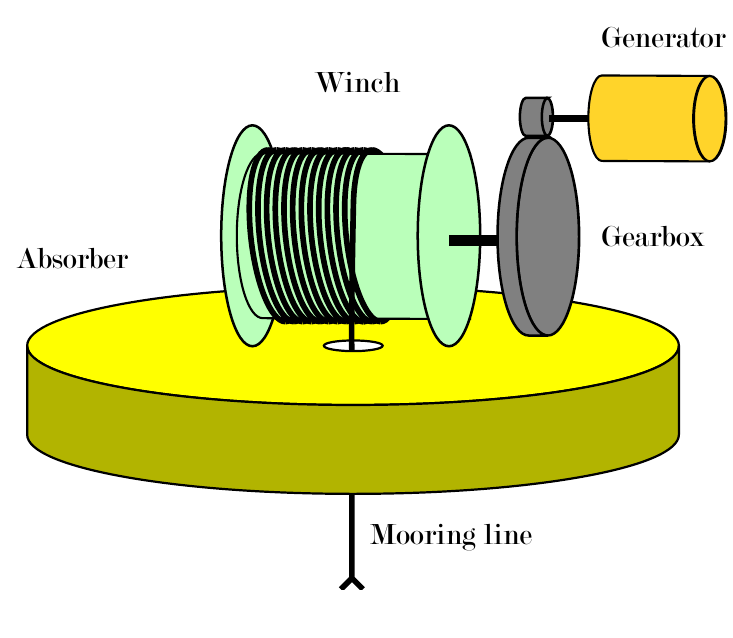
Figure 7. Array design. ( a ) Array configuration; ( b ) Electrical